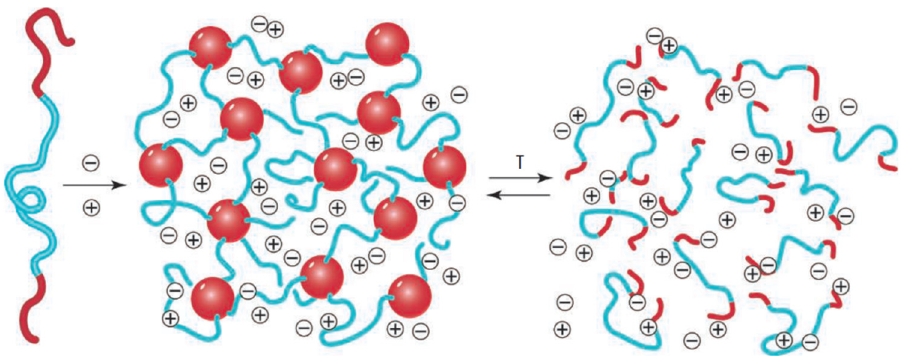
Figure 8. Thermally reversible ion gel based on an ABA triblock copolymer. The blue block is soluble in the ionic liquid, indicated as (+)( − ), and the red block is insoluble at room temperature and becomes soluble upon heating. Reprinted from Ref. [252] with permission from AAAS .